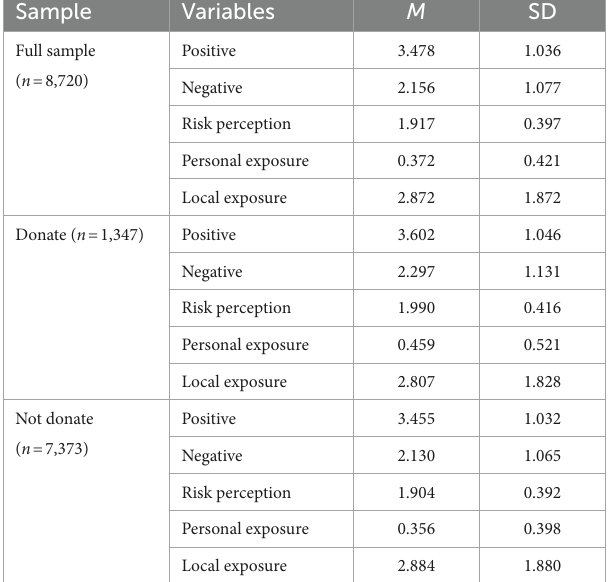
TABLE 2 Descriptive statistics of the measures.